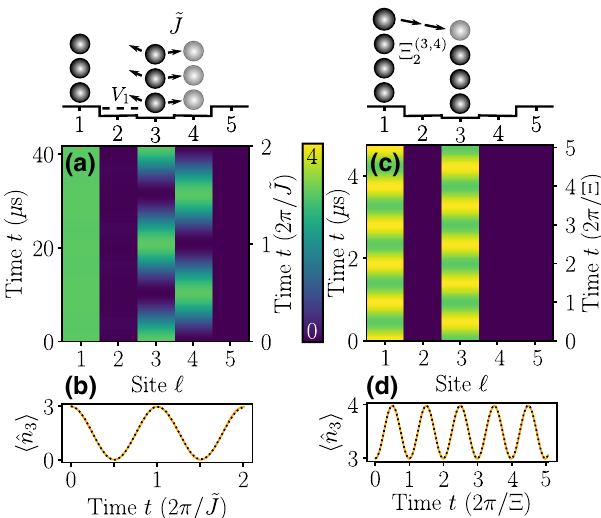
FIG. 4. Long-range quasiparticle-quasiparticle repulsion and exchange of distinguishable quasiparticles within a bound pair. (a),(c) The local occupations (cid:2)ˆ n (cid:3) (cid:3) as a function of the site index (cid:3) and time t . (b),(d) The occupation of the site (cid:3) = 3 as a func- tion of time t , simulated using the full Hamiltonian of Eq. (1) (solid yellow) and the effective Hamiltonian formed by adding the interaction term of either Eq. (22) (b) or Eq. (24) (d) to the effective single-quasiparticle Hamiltonian (14) (dotted